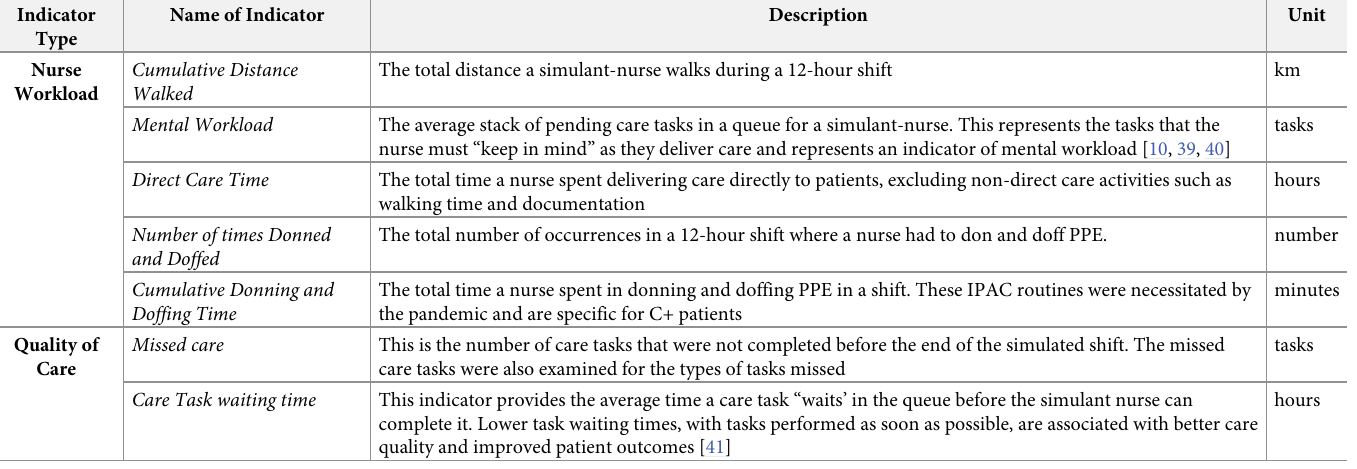
Table 2. Indicators of nurse workload and quality of care quantified in this study. Indicator